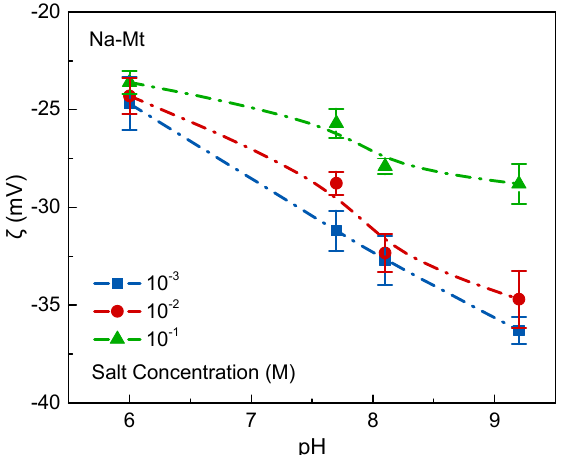
Figure 5. The changes in zeta potential of Al 2 O 3 , SiO 2 , and Na-Mt edges as a function of pH in the presence of 10 − 2 M NaCl concentration.